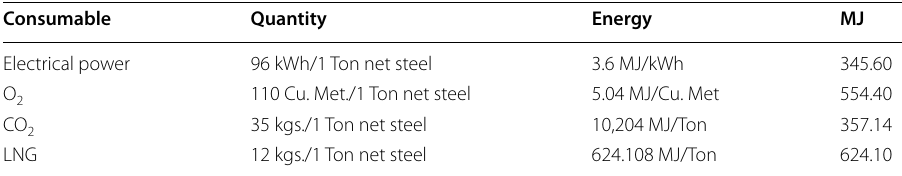
Table 2 Consumables for per ship one ton